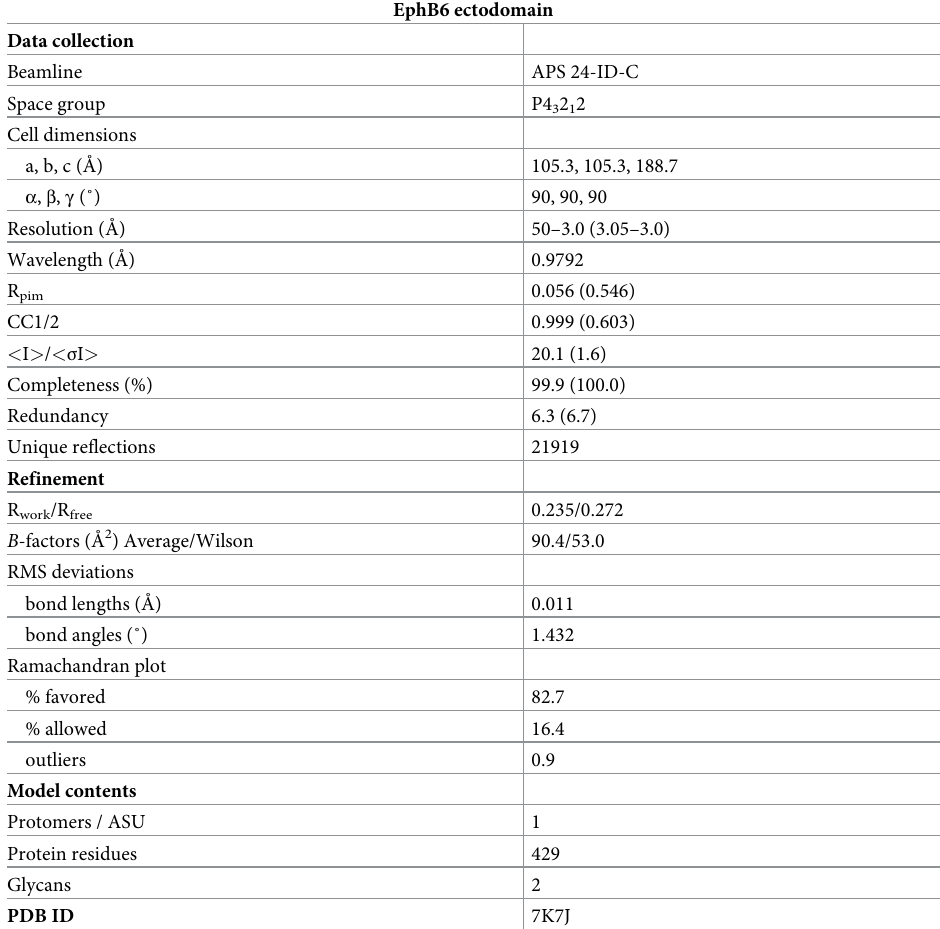
Table 1. Crystallographic data and refinement